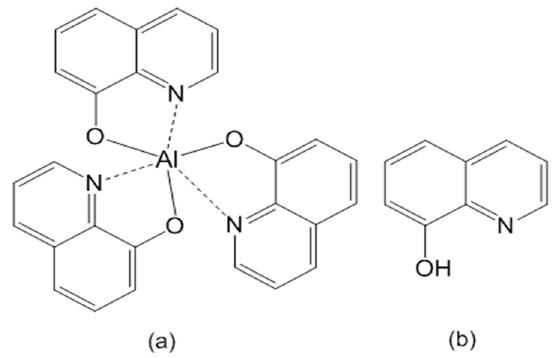
Figure 1. Molecular structures of ( a ) Alq 3 and ( b ) HQ species.